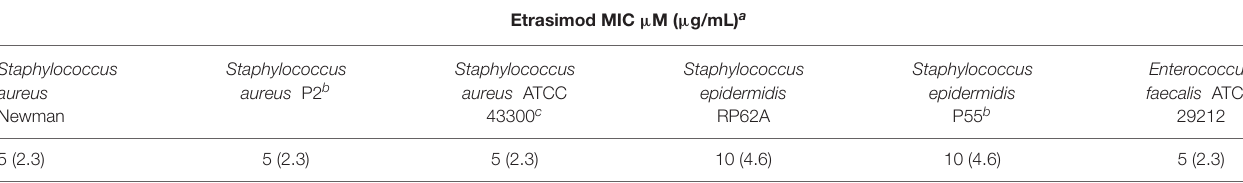
TABLE 3 | Minimum inhibitory concentrations of etrasimod against tested Gram-positive bacterial species.